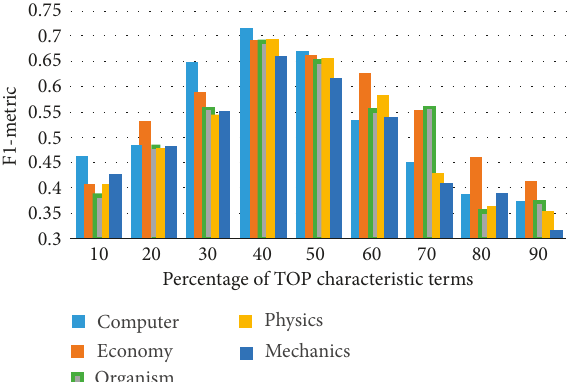
Figure 7: F1-metric comparison of various percentage top characteristic